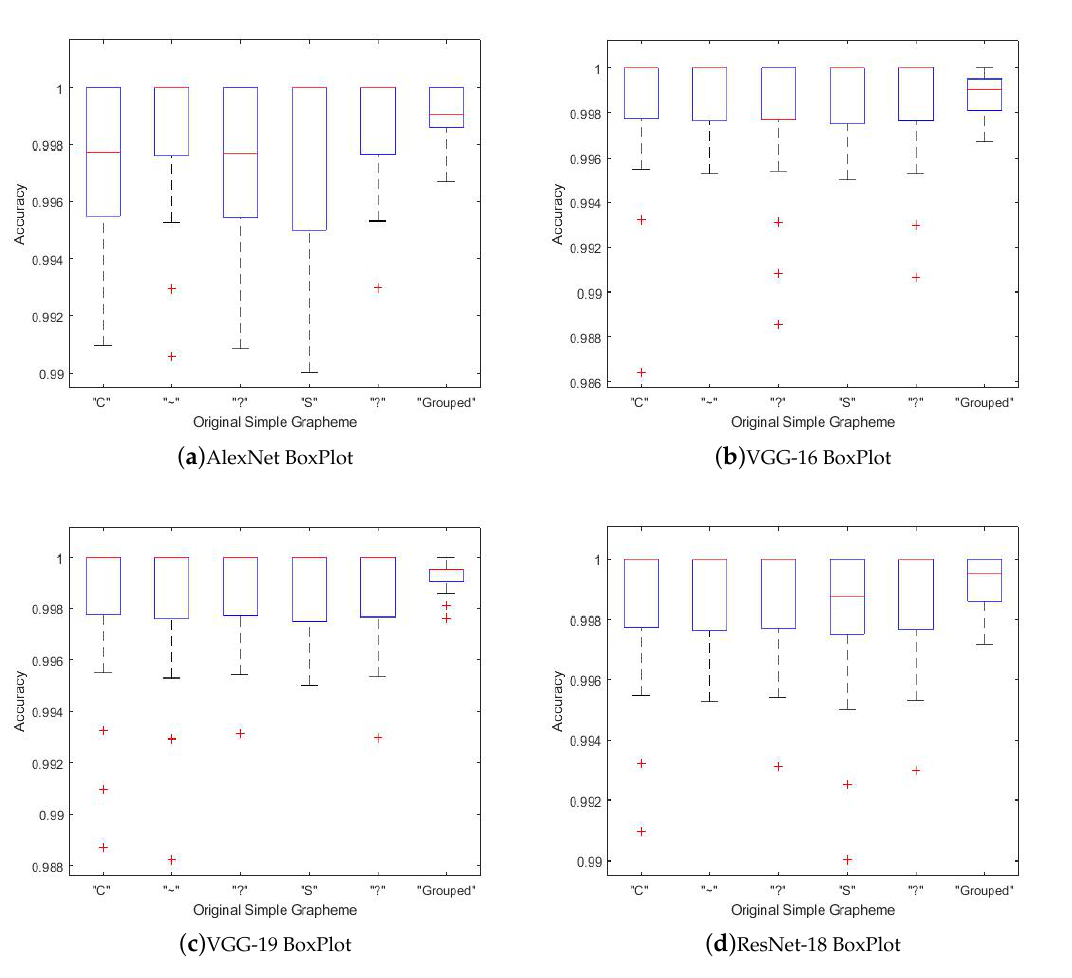
Figure 11. BoxPlots of Test Classification.